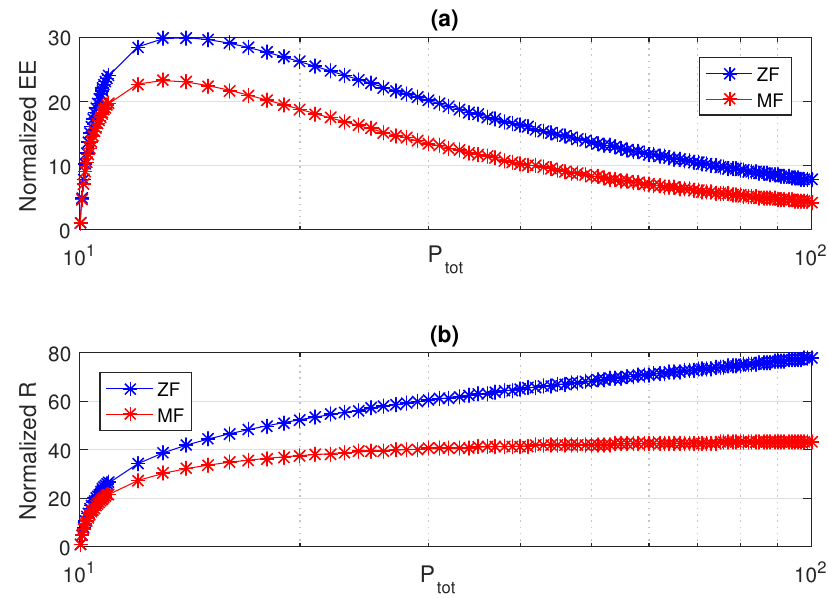
Figure 2. ( a ) Normalized EE versus P tot ; ( b ) Normalized R versus P tot , when N t = 400, K =